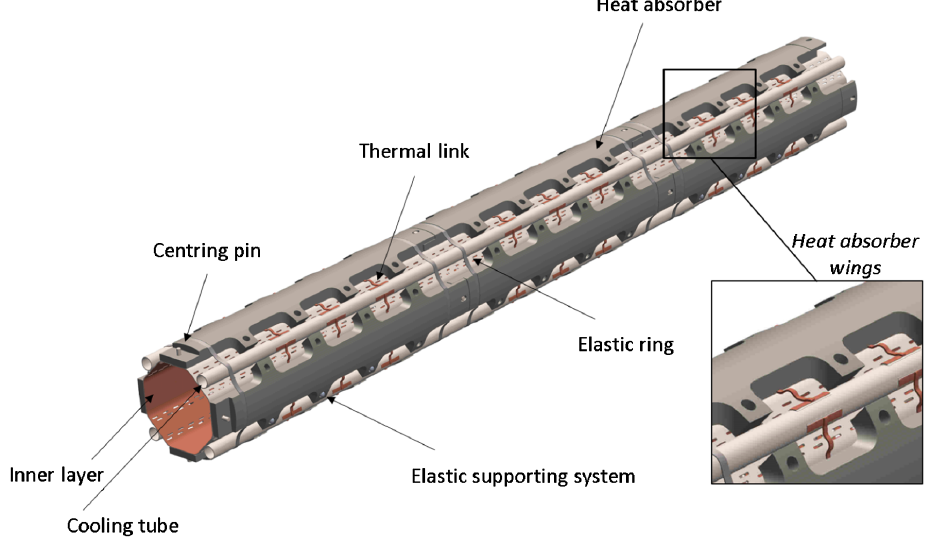
FIG. 8. The new Q1 HL-LHC beam screen.